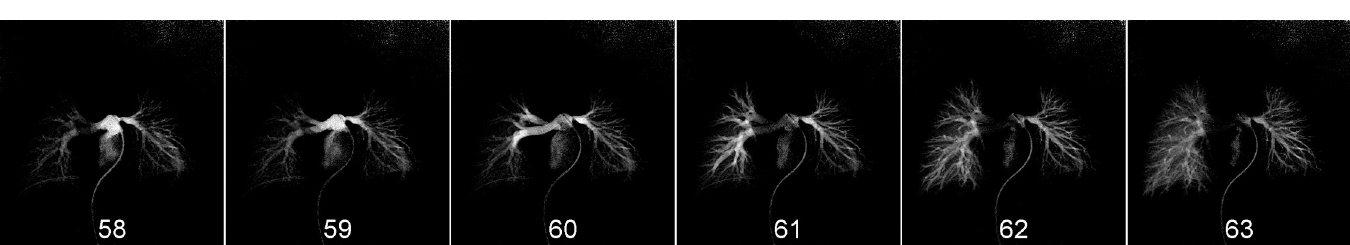
Fig 9. Baseline subtracted images by X-ray pulmonary angiography (XA). The numbers at the bottom of each image are the frame number of acquisition. The torrent period during the second cardiac cycle started from frame 58. Therefore, the time window for calculation was set to start from frame 59 (13% of the R-R interval in the torrent period), in which the contrast agent had flowed from the main pulmonary trunk to the first branch of both the right and left pulmonary artery. The time window for acquisition ended at frame 63 (43% of the R-R interval in the torrent period), in which the contrast agent had filled the entire lung field before passing through. The difference in the signal intensity between frames 59 and 63 of the ROI in each lung was calculated as the net increase in signal intensity.